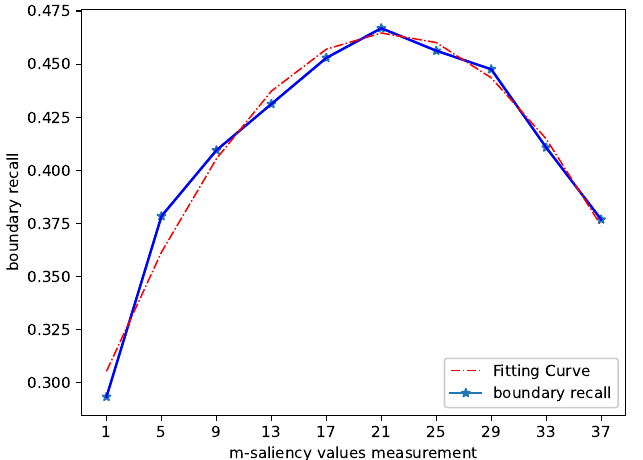
Figure 7. The boundary recall statistics of different m ; the red curve is the fitting result of bound- ary